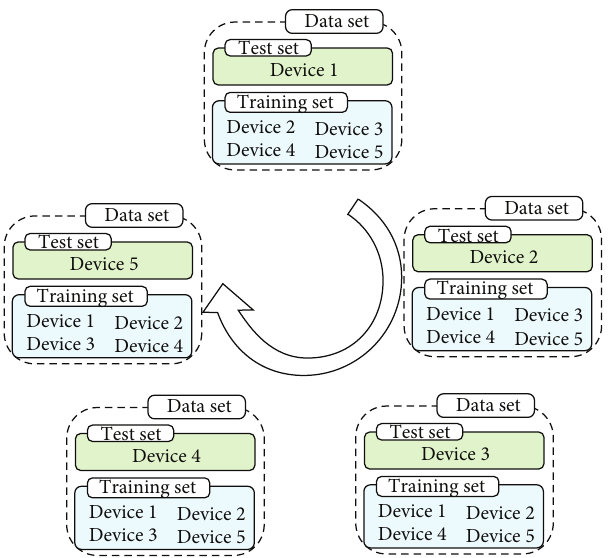
Figure 6: Detection results of respective